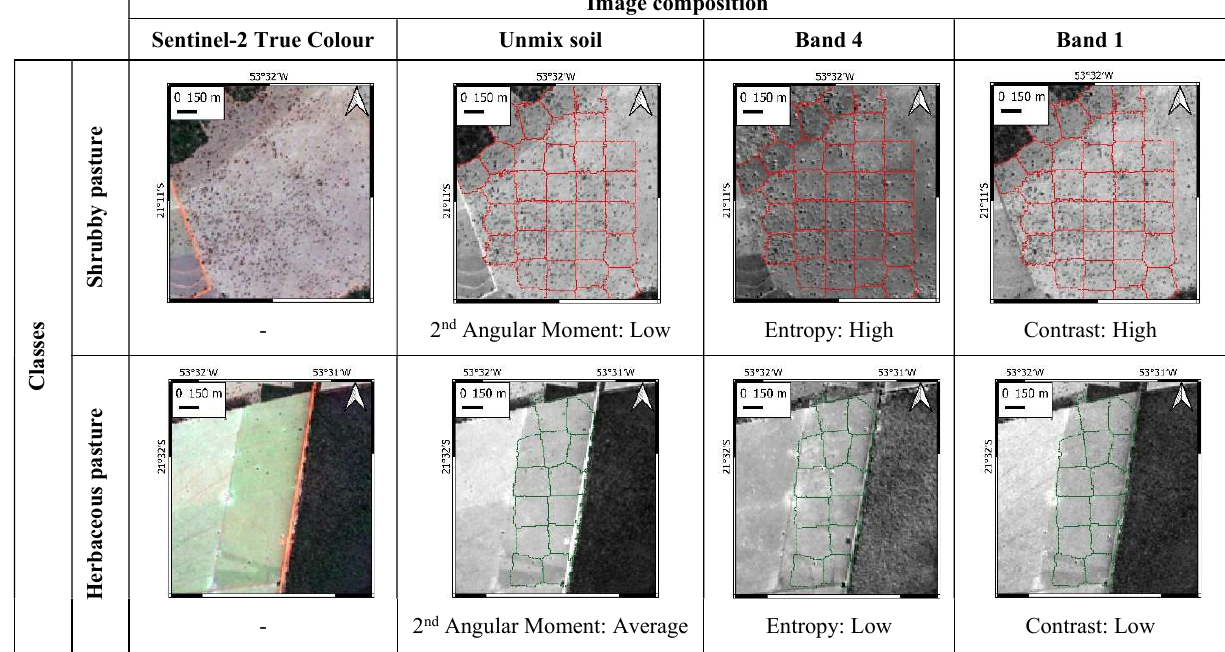
Table 7: Examples for the classes of shrubby pasture and herbaceous pasture on several image compositions: Sentinel-2 true colour, the soil component of the spectral unmixing, the near infrared band and the blue band. In red dashed lines the superpixels corresponding to the shrubby pasture class and on green dashed lines the ones corresponding to the herbaceous pasture class and how the respective texture values were for each class on each image